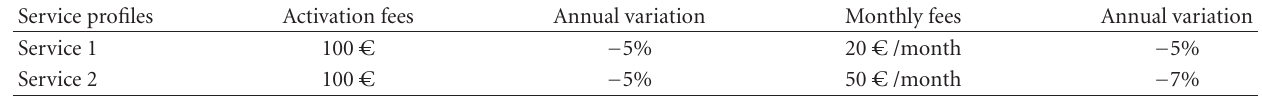
Table 5: Service profile characteristics (retail prices).